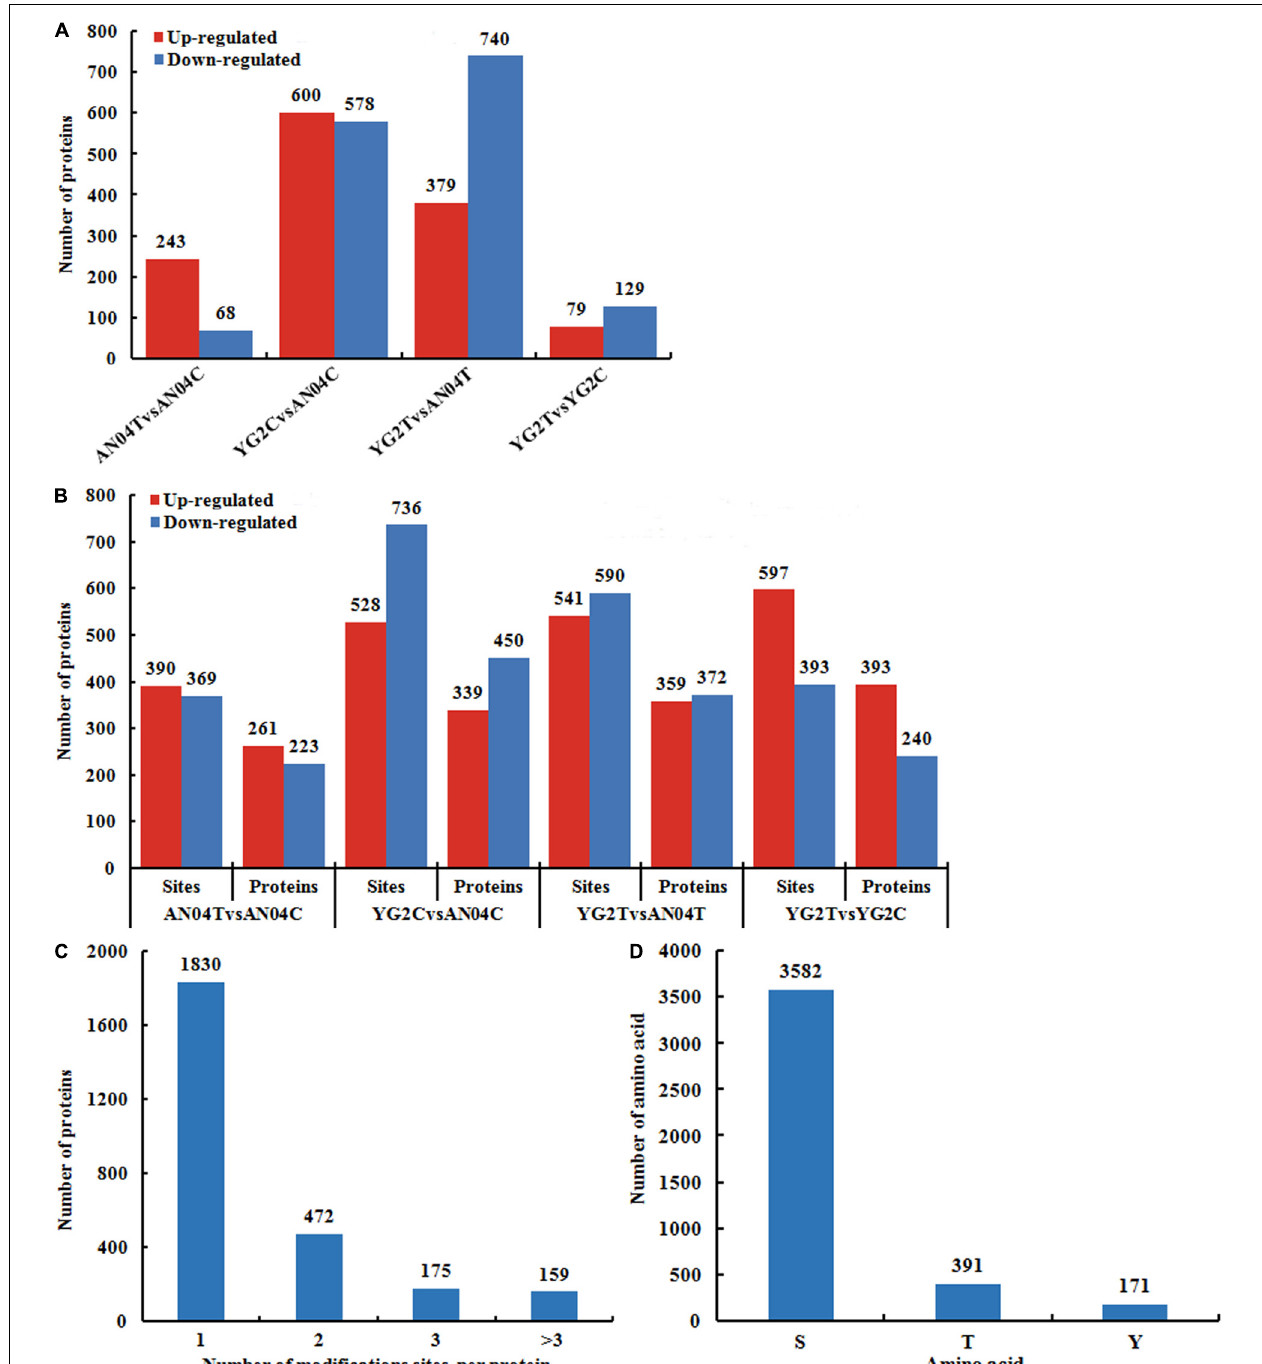
FIGURE 2 | Overview of the identified proteins and phosphorylation sites in An04 and Yugu2 in response to salt stress. The numbers of DAPs (A) , DRPPs and phosphorylation sites (B) in different comparison groups. (C) Distribution of proteins containing different numbers of phosphorylated sites. (D) Distribution of phosphorylated amino